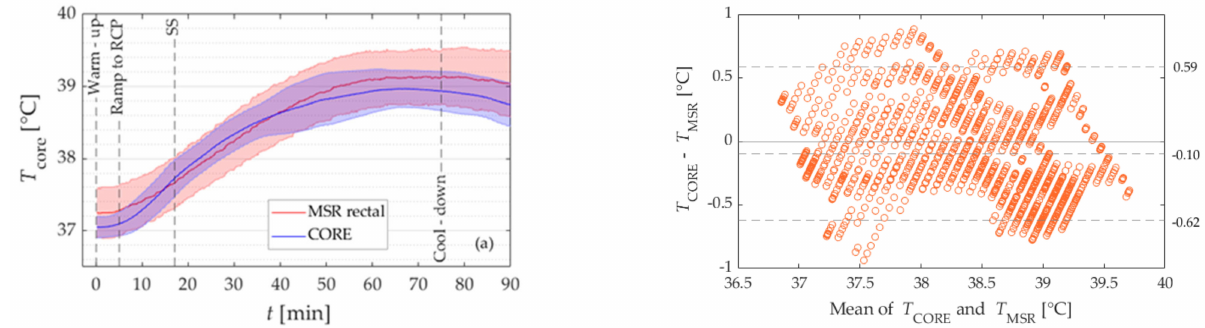
Figure 3. The mean temperature (and standard deviation, the shaded areas) during the entire exercise protocol execured in connection with Study II as determined with the MSR rectal sensor (red) and CORE sensor (blue) sensor. ( b ) Bland-Altman plot of the data in ( a ). The dashed lines represent the limits of agreement (LoA) and bias for the entire